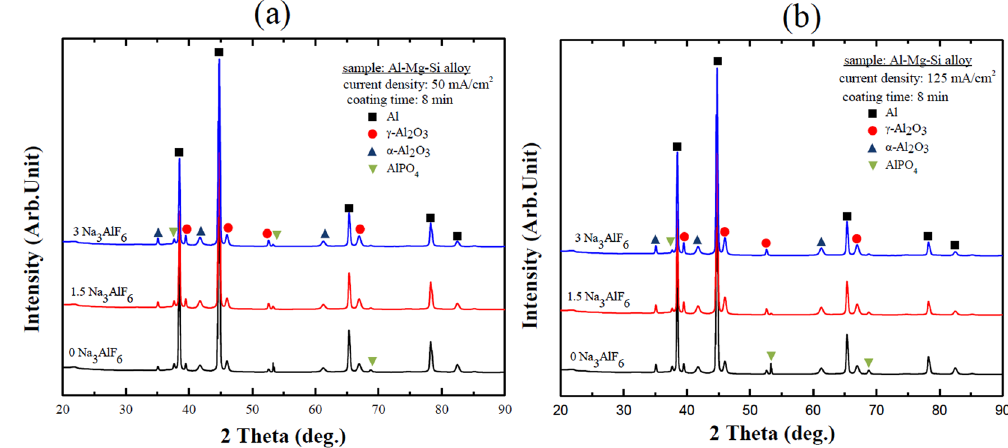
Figure 4. XRD patterns of the coatings formed on al Al-Mg-Si alloy by PEO at ( a ) 50 mA/cm 2 and ( b ) 125 mA/ cm 2 using electrolytes containing different concentrations of Na 3 AlF 6 .